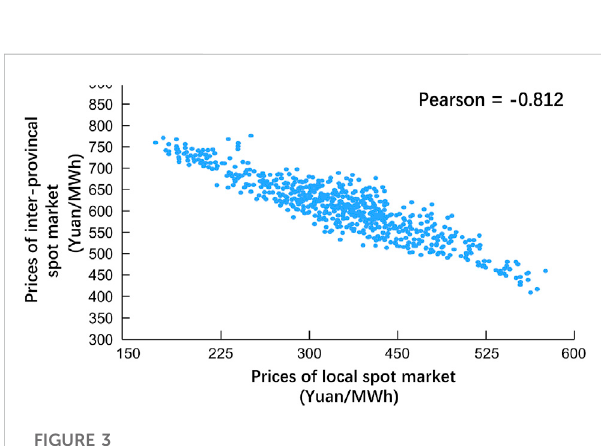
FIGURE 3 Correlation analysis of simulated electricity prices in local and inter-provincial spot markets.